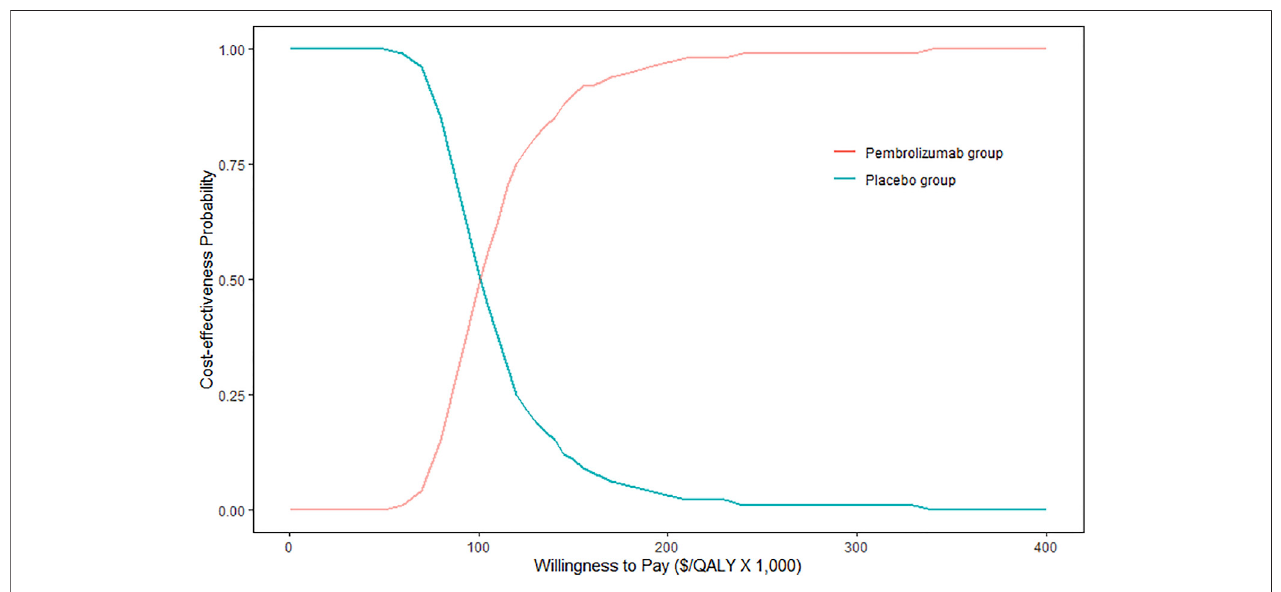
FIGURE 3 | Cost-effectiveness acceptability curve. QALY, quality-adjusted life year.